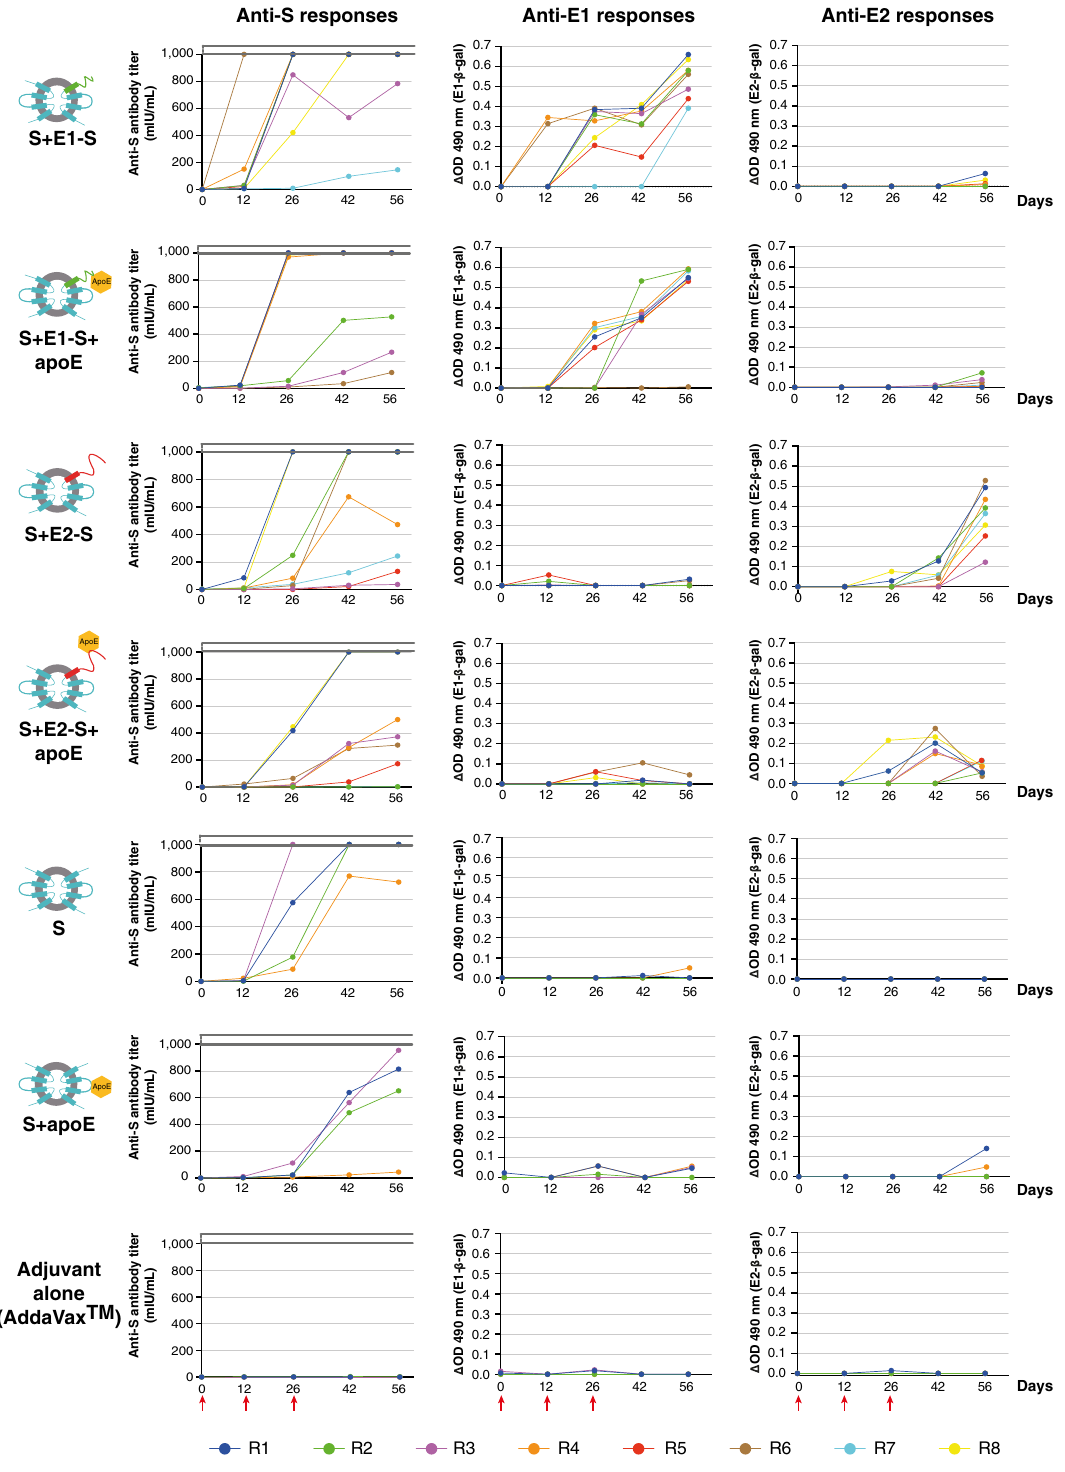
Figure 4. Humoral immune responses in rabbits immunized with HBV–HCV subviral particles with and without apoE presentation, with the AddaVax adjuvant. Specific anti-E1/anti-E2 and anti-S responses were evaluated in rabbit sera with “in-house” ELISAs and a routine immunoassay (ARCHITECT), respectively. Sera from rabbits immunized with S, S + apoE and AddaVax adjuvant alone were used as controls. Results for anti-E1/anti-E2 responses are expressed as the difference (Δ) in OD (490 nm) (anti-E1 or anti-E2—β-Gal), whereas anti-S titers are expressed in mIU/mL. Red arrows indicate the time at which immunizations occurred (days 0, 14 and